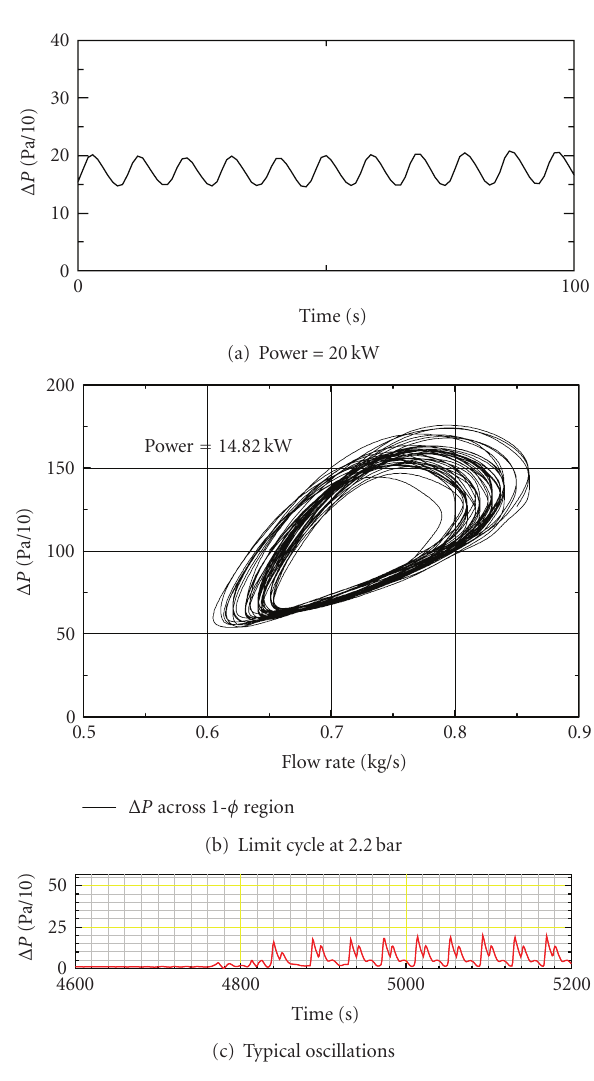
Figure 16: Some typical type-1 oscillations and the limit cycle for observed for 49.3 mm i.d.